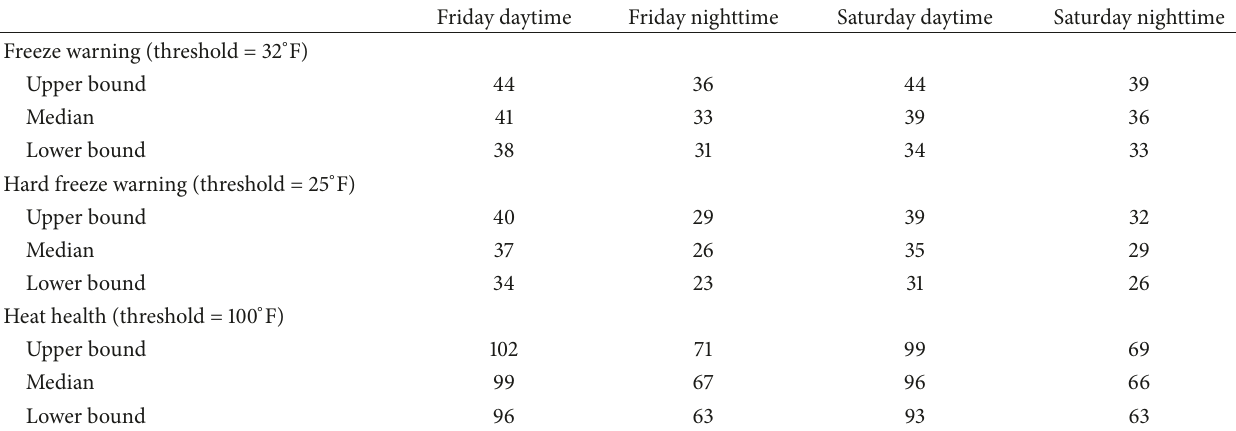
Table 1: Forecast temperature values in degrees Fahrenheit ( ∘ F).